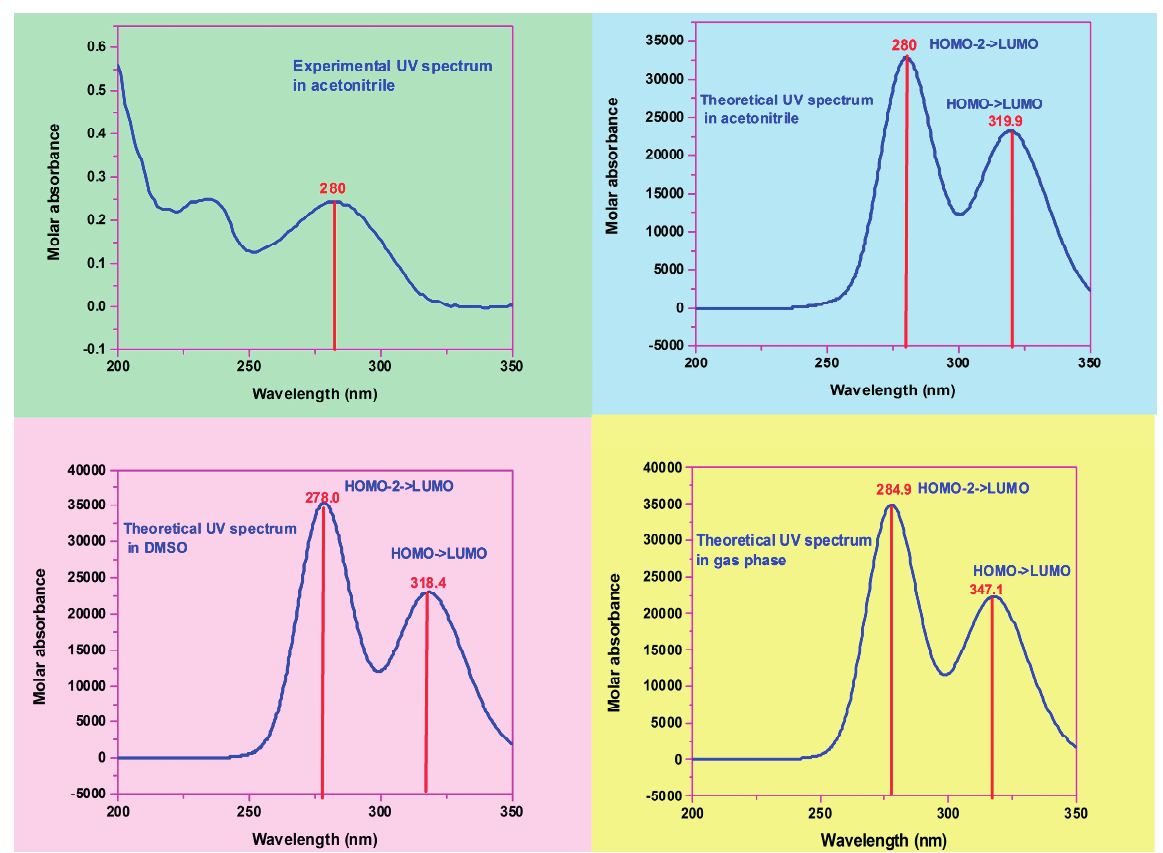
Figure 4. Theoretical (B3LYP) and experimental UV-Vis spectra of (2 E